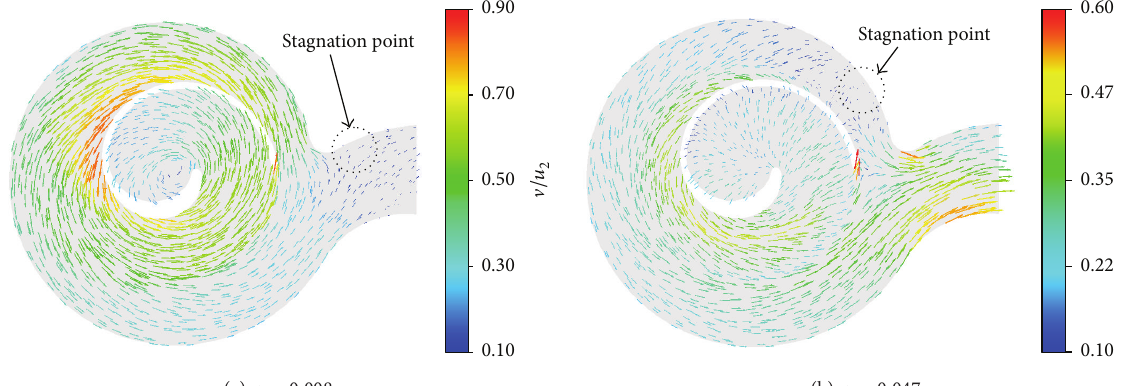
Figure 13: Absolute velocity vectors ( 𝛽 𝑏2 = 8 , 𝜃 0 = 0 ∘ ).